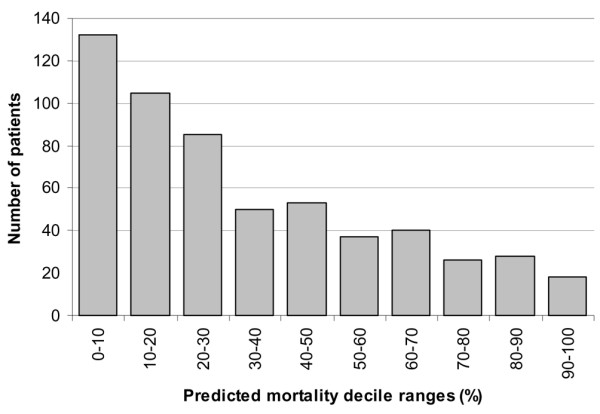
Histogram of patients in risk of death ranges: UK APACHE, Royal Berkshire Hospital, 1 January 2003 to 30 June 2004.